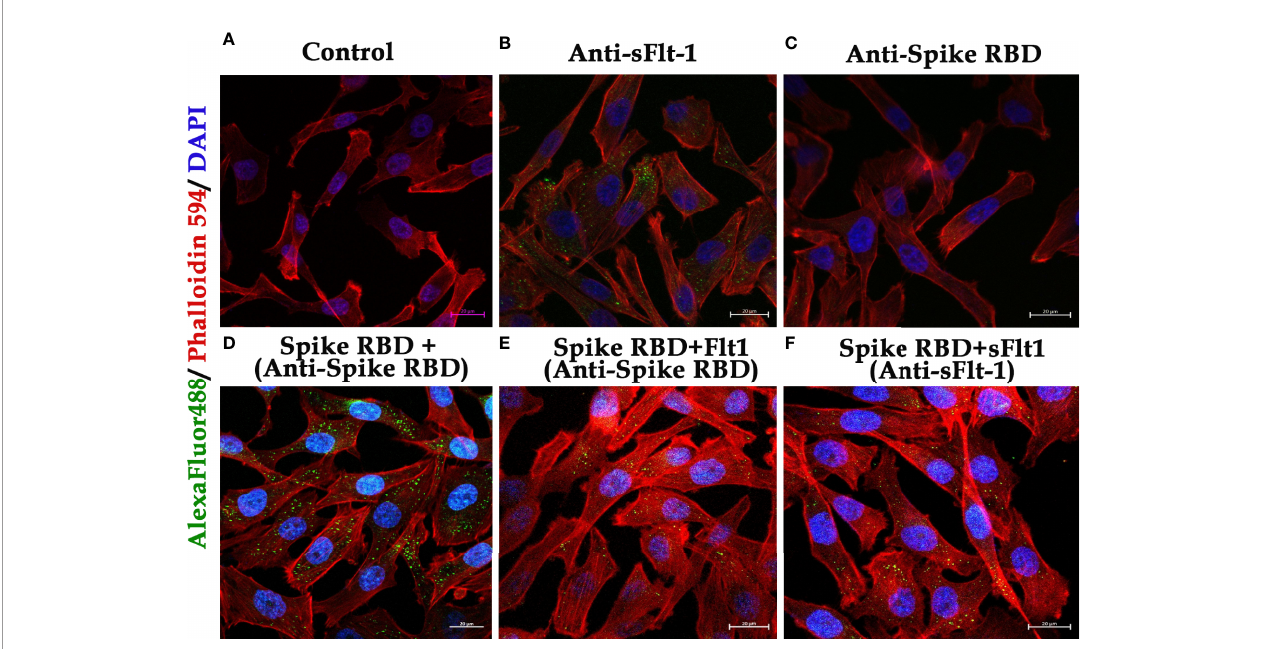
FIGURE 7 | Immuno fl uorescence of MDA-MB 231 cells in 2D culture to demonstrate binding of rspike RBD to Flt1-1 receptors: (A) Control (cells only without any treatment) (B) Cells probed with anti-Flt-1 antibody. (C) Cells probed with anti-spike RBD antibody. (D) Cells were treated with rspike RBD and probed with anti- spike RBD. (E, F) Cells were treated with a pre-incubated rspike RBD and rsFlt1 and probed with either anti-spike RBD or anti-sFlt-1 respectively, which shows a lack of fl uorescence signals as a result of binding of the two proteins during pre-incubation. The scale bar is present on each captured image, indicating 40X magni fi